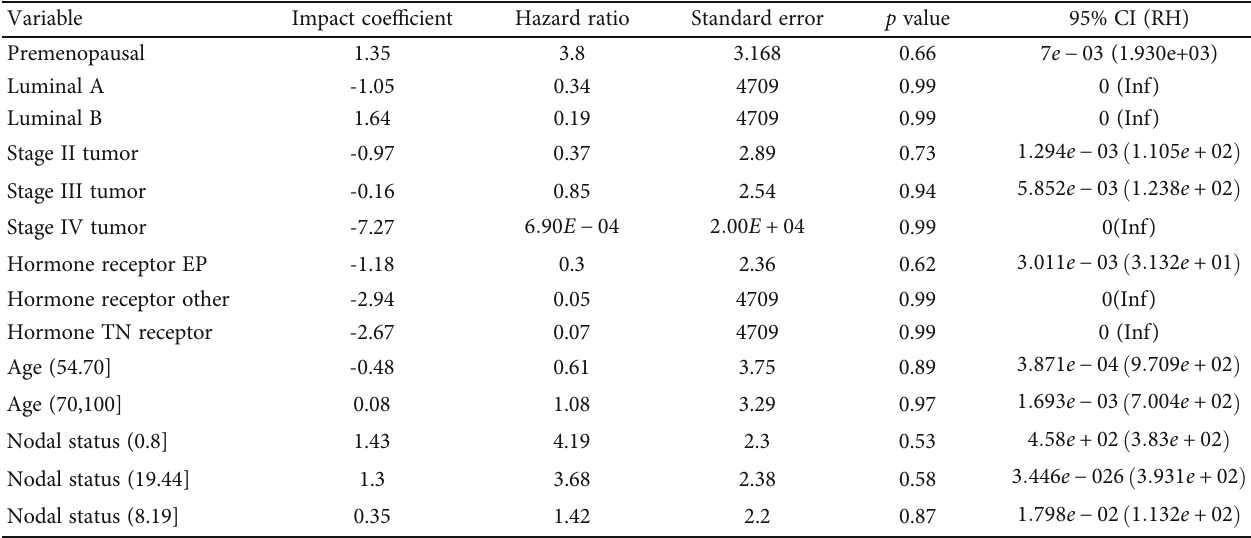
Table 7: Impact index, standard error, risk index, p value, and 95% con fi dence intervals using the Cox model in conjunction with TCGA.